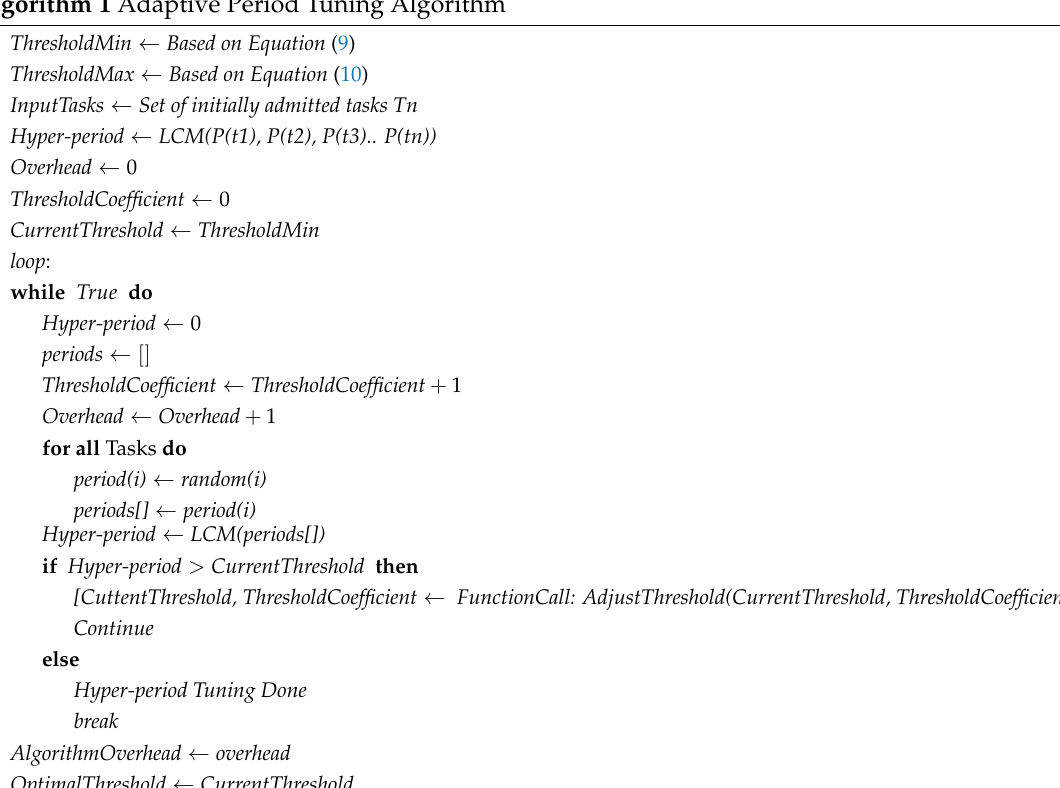
Algorithm 1 Adaptive Period Tuning